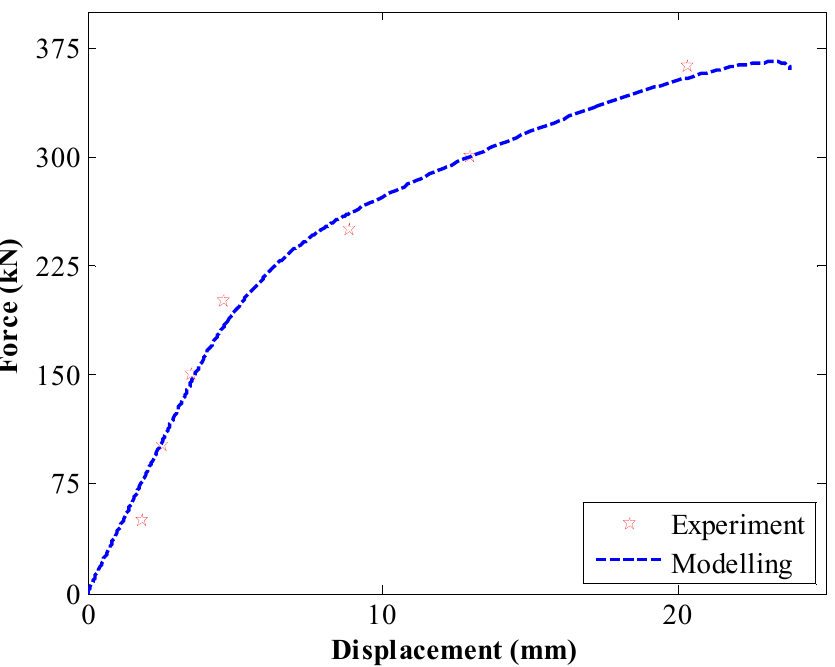
Figure 2. Comparison between experimental test and modelling [26].